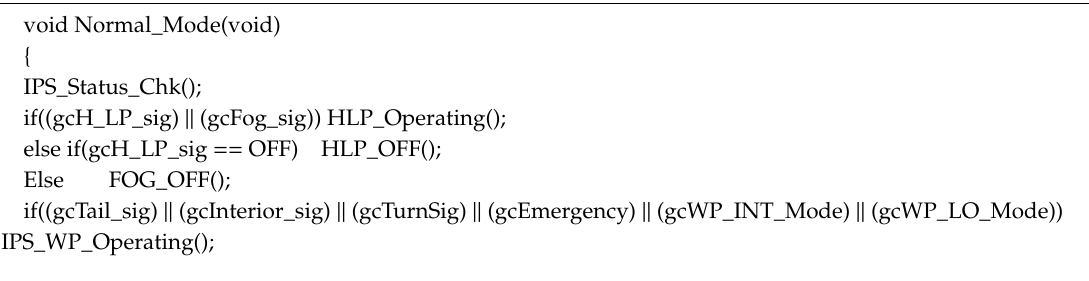
Algorithm A2. SJB Normal Mode(IPS Control)